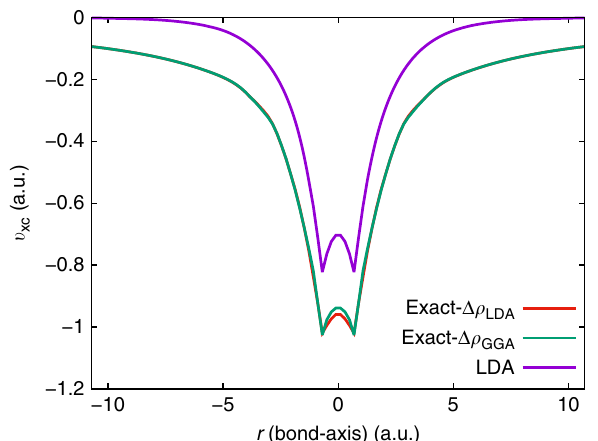
Fig. 5 Exchange-correlation potentials ( v comparison is provided between the exact and the LDA-based v The exact exchange-correlation potential is evaluated using the cusp- corrected con fi guration interaction (CI) density. The effect of the choice of the functional used in evaluating the cusp correction is demonstrated using two different functionals — LDA ( exact (cid:3) Δ ρ